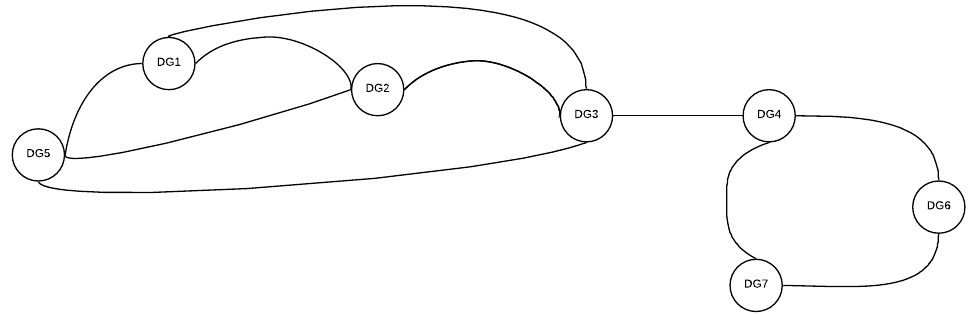
Figure 5. Communication network topology using a graph